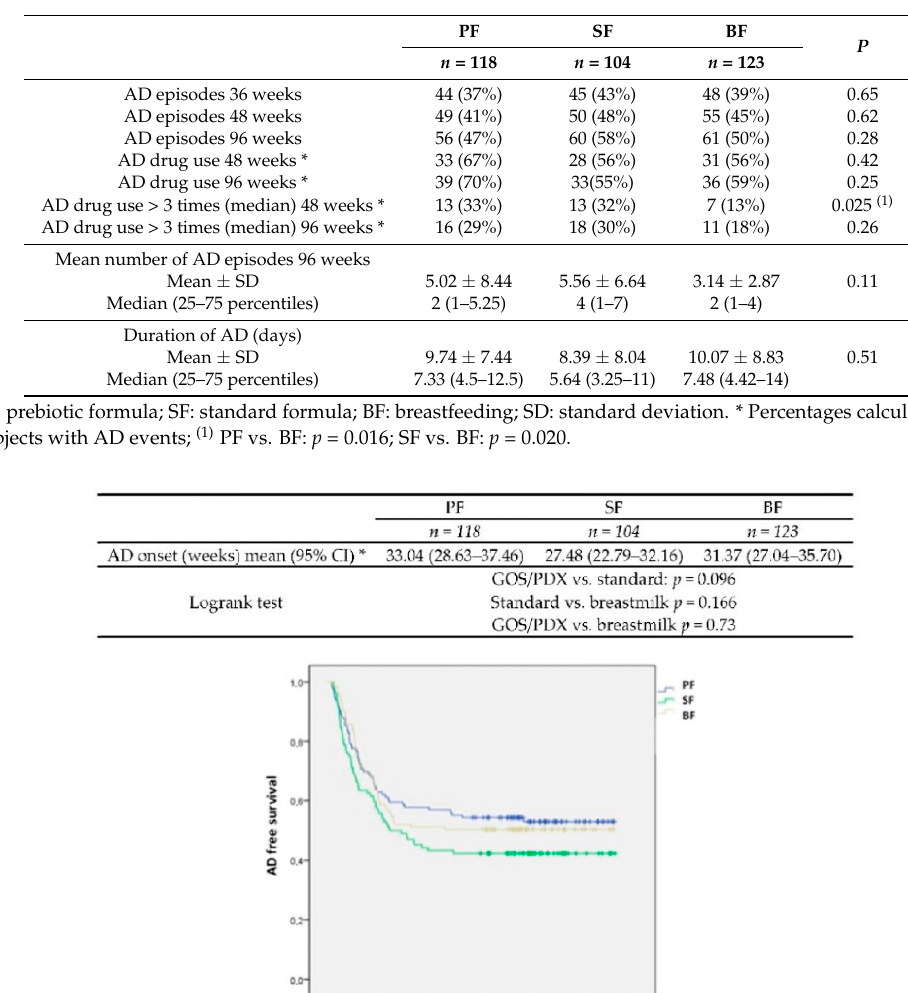
Table 2. Atopic dermatitis (AD) parameters in the three nutritional groups.